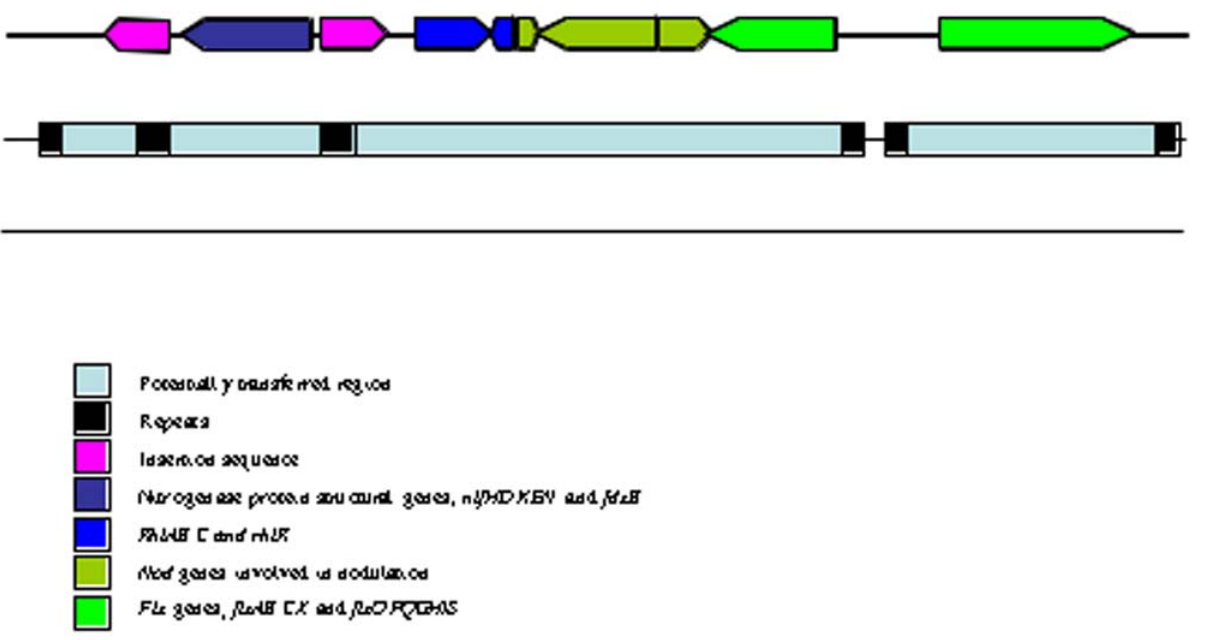
Figure 7. Diagram of the R.leguminosarum major nitrogen fixation gene cluster. - This cluster represents a potentially laterally transferred region of DNA. Major nitrogen fixation genes are represented as blocks and are as shown in the color key.